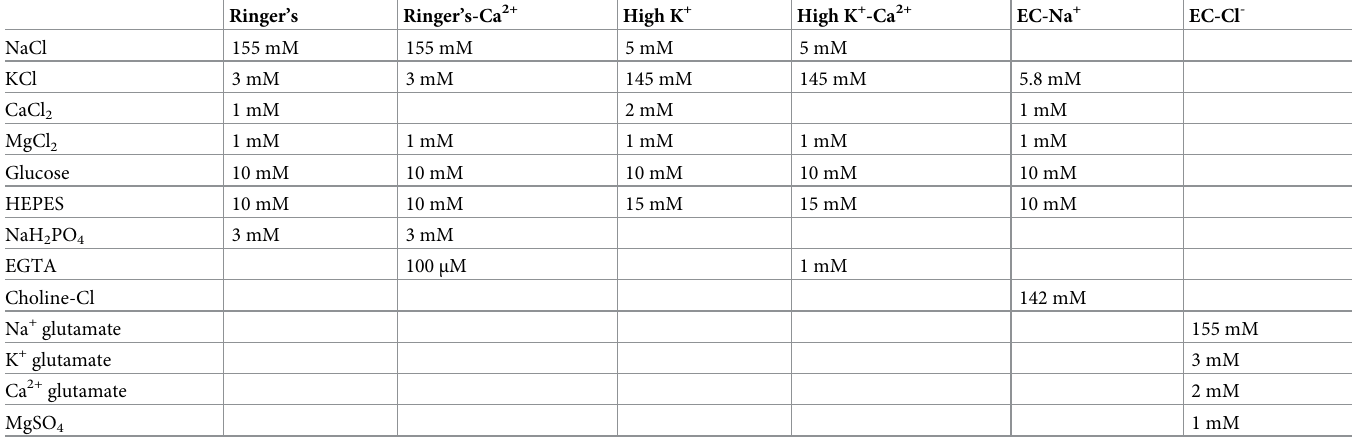
Table 1. Ion composition of buffers used in this